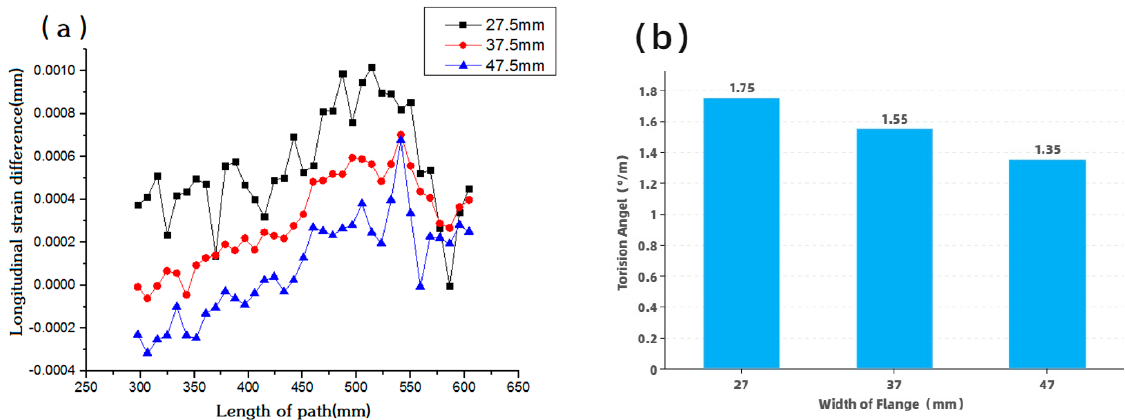
Figure 9. Simulation results of different widths of the flange. ( a ) Influence of different width of flange on torsion; ( b ) Torsion decrease 0.2°/m with an average 10 mm increase in width of flange.